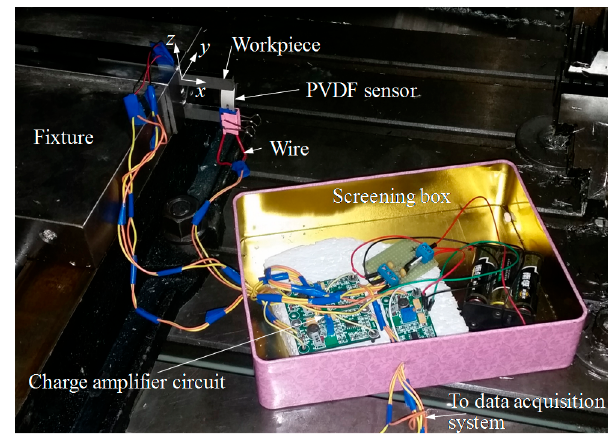
Figure 5. Experimental setup.